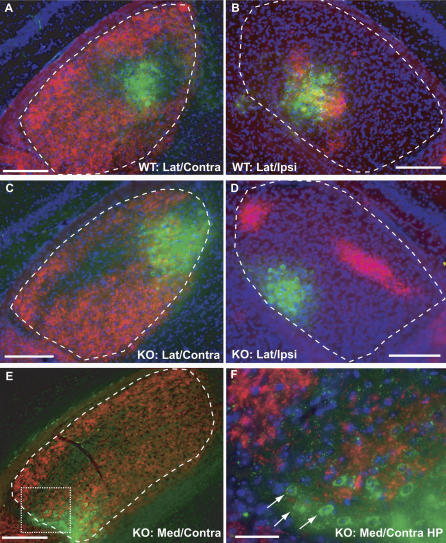
The Retinogeniculate Mismatch Is Transferred to the CortexCoronal sections through the dLGN in adult WT (A) and (B) and KO (C–F) mice following anterograde transport of red CTB from the ipsilateral (Ipsi) (B) and (D) or contralateral (Contra) (A), (C), (E), and (F) eye and of green CTB from either the lateral (Lat) (A–D) or medial (Med) (E) and (F) region of cortical area 17. In WTs, the location of dLGN cells retrogradely labelled from the lateral (binocular) region of area 17 corresponds well with the position of ipsilateral retinal terminals (B), or with the gap in the position of the contralateral retinal terminals, which corresponds to their location (A). All retrogradely cells are located either within, or close to, the ipsilateral patch. In KOs (C) and (D), the position of cells retrogradely labelled from lateral area 17 is similar to WTs. In the dorsal region of the nucleus, this shows some overlap with the location of the ipsilateral patch. However, since the ipsilateral patch is narrower and extends much more ventrolaterally, many of the retrogradely labelled cells are located at some distance from the ipsilateral patch; no retrogradely labelled cells are seen in the ventrolateral region of the ipsilateral patch following injections into lateral area 17, suggesting that geniculocortical connections have not changed in a compensatory manner in KOs. Following injections into medial area 17 (E), retrogradely labelled cells are seen in the ventral region of the nucleus. In KOs, the retrogradely labelled cells are in close proximity to the ventral expansion of the ipsilateral patch. The boxed region is shown at higher power (Contra HP) in (F). Most significantly, retrogradely labelled dLGN neurons (some highlighted with arrows) are seen both within and beside the ipsilateral patch. Scale bars indicate 200 μm in (A–E) and 40 μm in (F).